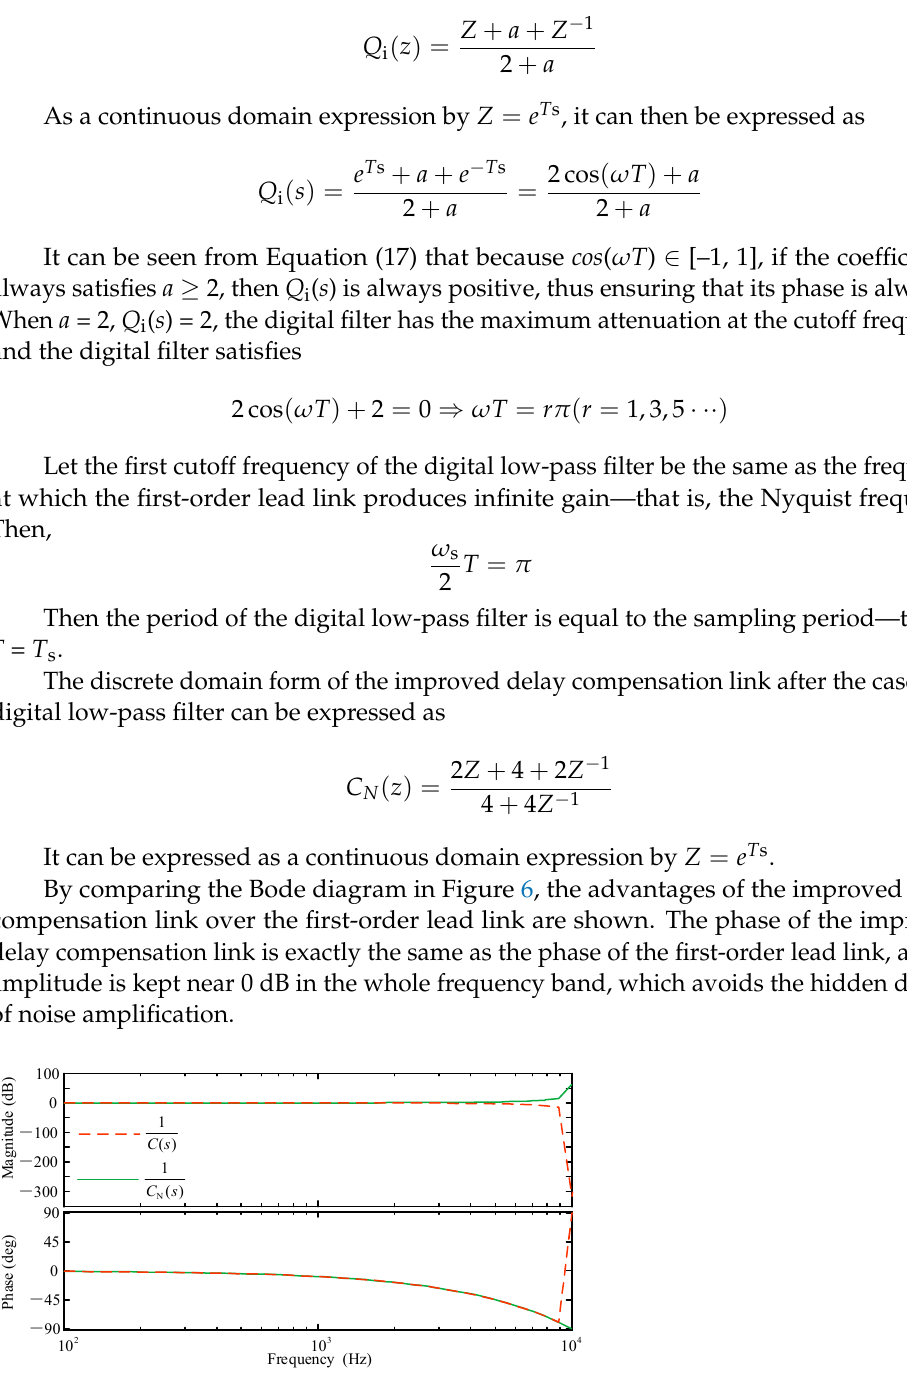
Figure 6. Comparison of new delay compensation function with first-order lead link.